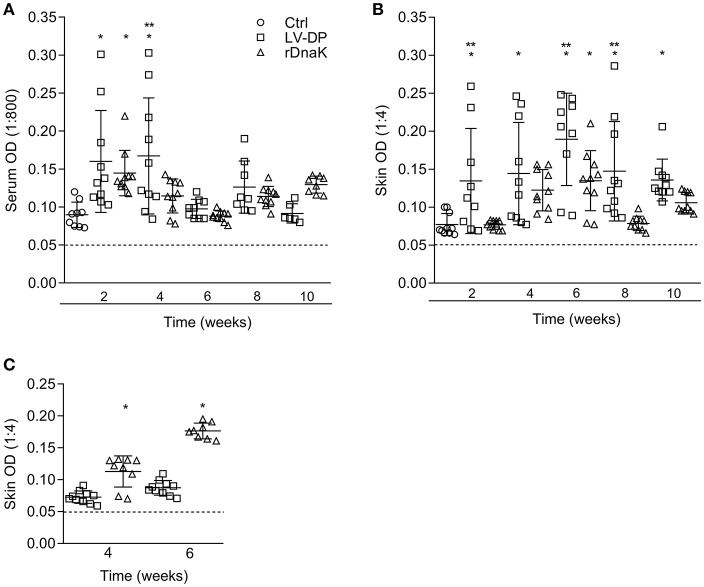
Evaluation of antibodies generated against F. columnare ECP and recombinant DnaK protein. The different groups are labeled as indicated in the figure. (A) The serum IgM antibody titer (1:800) is the reciprocal of the maximum dilution at which we could reliably detect binding of antibody to F. columnare ECP. (B) The skin IgM antibody titer (1:4) is the reciprocal of the maximum dilution at which we could reliably detect binding of antibody to F. columnare ECP. (C) The skin IgM antibody titer (1:4) is the reciprocal of the maximum dilution at which we could reliably detect binding of antibody to F. columnare rDnaK. The mean absorbance ± SD for each group is shown as a horizontal line. Asterisk(s) denote a significant difference, P <0.05. (*), indicates a significant difference when compared to the non-immunized control; (**), indicates a significant difference between immunized groups. The dashed line represents the mean background absorbance value observed using an isotype control.